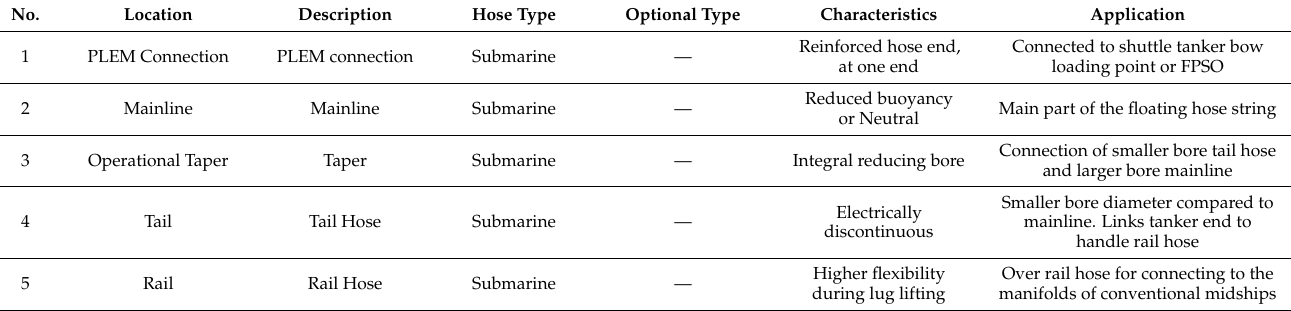
Figure 19. Multi buoy mooring (MBM) hose configuration. Table 5. Arrangement of the multi buoy mooring